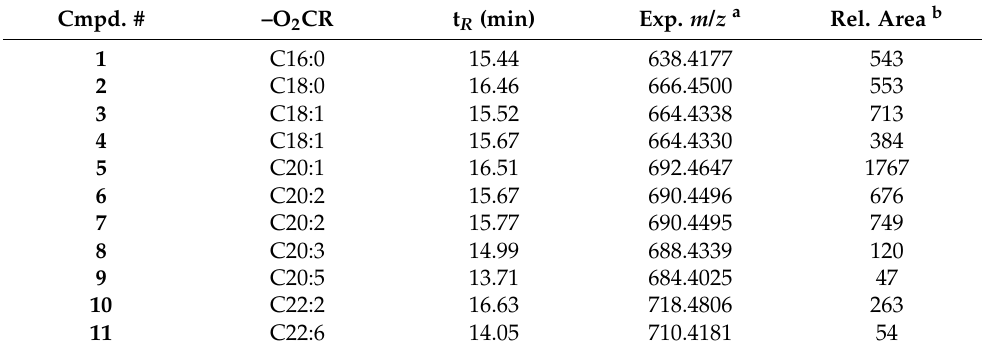
Table 3. OC–fatty acid conjugates annotated in H. diversicolor worms exposed to OC. Cmpd. #